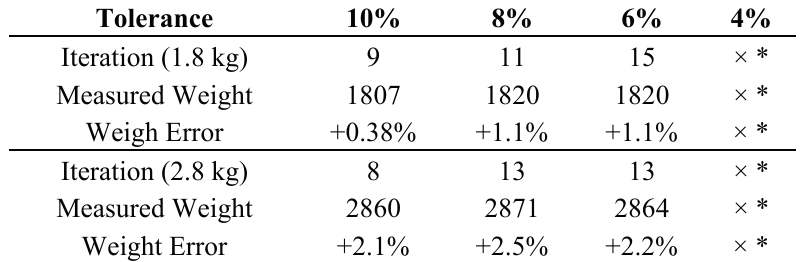
Table 6. Required iterations for automatic force distribution with arbitral load and different tolerance